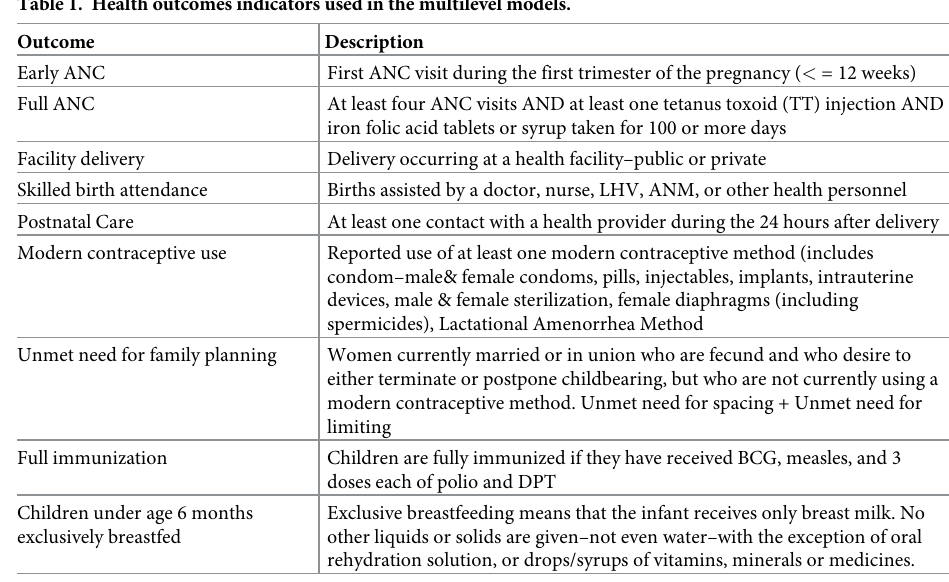
Table 1. Health outcomes indicators used in the multilevel